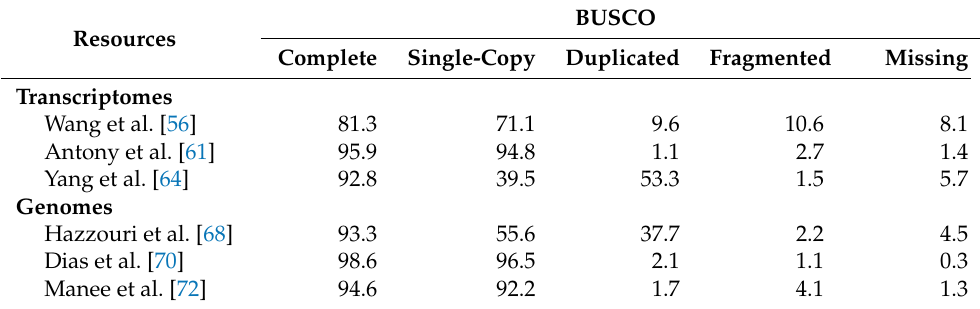
Table 1. Single-copy ortholog statistics for available transcriptome and genome assemblies of the red palm